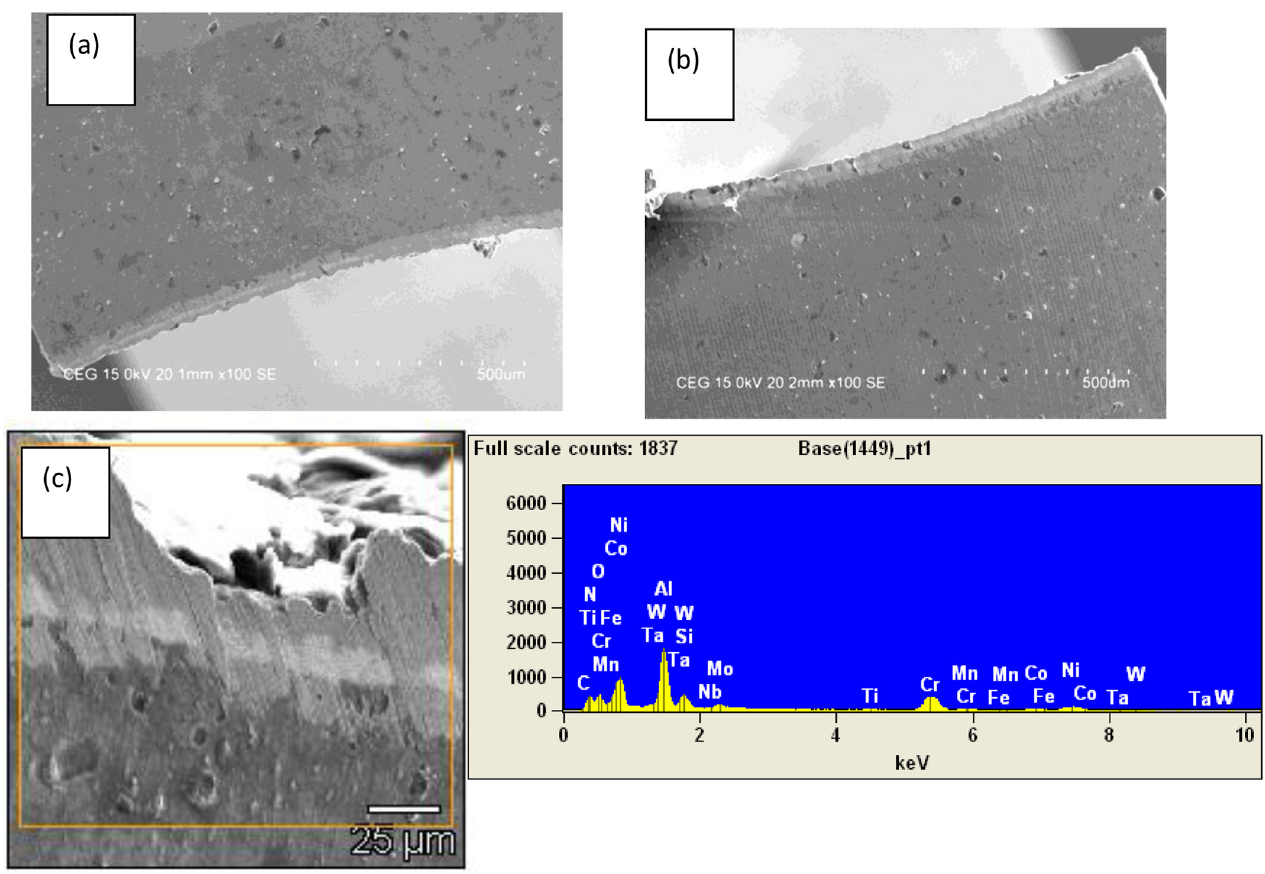
Fig. 13. (a-c) SEM Images of worn out drill at (a) N=1250 (rpm), f =0.05 (mm/rev), P =500* 10 3 (Pa), NP=1.5% (g): (VB-42 m m), (b) N=1000 (rpm), f= 0.125 (mm/rev), P =750* 10 3 (Pa), NP= 1.5% (g): (VB-59 m m) and (c) EDS analysis of worn out drill at N=1250 (rpm), f =0.125 (mm/rev), P = 2500* 103 (Pa), NP =1% (g): (VB-69 ( m